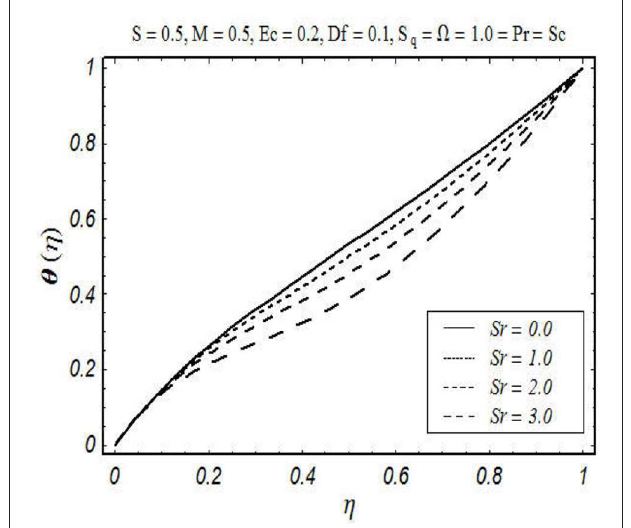
FIGURE 7 | Sketch of temperature distribution θ (η) for Soret number Sr .